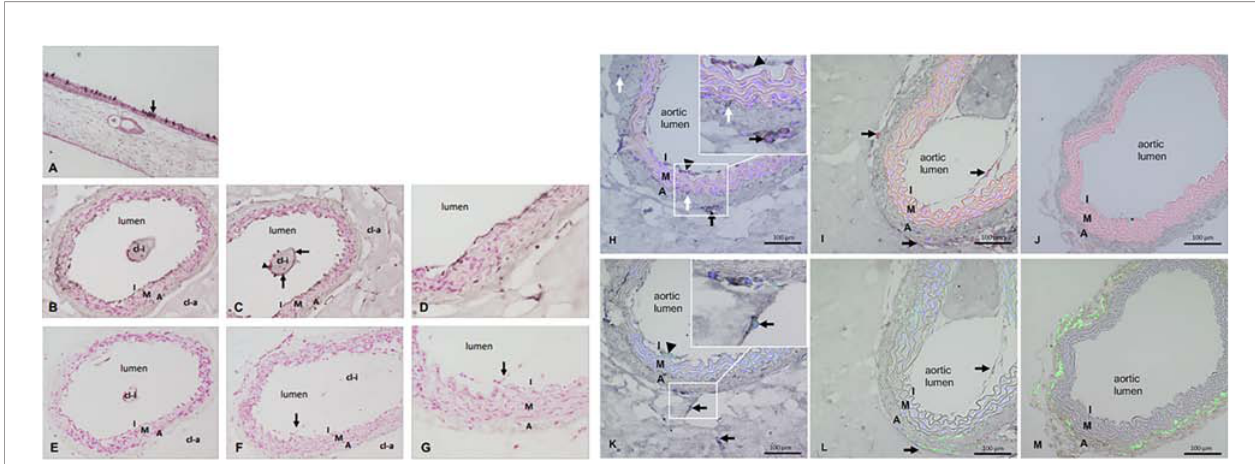
FIGURE 4 | (A – M) Immunostaining for SARS-CoV-2 and double immunostainings for SARS-CoV-2 plus ACE-2 or SARS-CoV-2 plus CD34. (A) SARS-CoV-2 staining of the nasal mucosa (used as positive control) and single epithelial cells show the dark signals (arrow) indicating SARS-CoV-2 infection. (B – D) Tissue sections of mouse aorta after ARA and SARS-CoV-2 infection. Dark signals in the innermost layer called intima (I). Single cells covering the collagen gel area inside the aortic lumen (cl-i) also stained positive for SARS-CoV-2 (arrows) while others are negative (arrowhead). (E) ARA section exposed to SARS-CoV-2 infection but treated by secondary antibody only in the immunostaining as control. (F – G) Tissue sections of ARA that were not exposed to SARS-CoV-2 infection but stained with both primary and secondary antibodies in the immunostaining procedure. Cells of the aortic intima that sprouted into the aortic lumen are also visible (arrow). Figure panels (A – G) Dark staining: SARS-CoV-2 staining, red staining: counterstaining with Calcium red, cl-i: collagen gel inside the aortic lumen, cl-a: collagen gel around the aortic wall, I: intima, M: media, A: adventitia. Figure panels (H – M) Double immunostainings for SARS-CoV-2 plus ACE-2 or SARS-CoV-2 plus CD34 on tissue sections of ARA and FIA. (H) : Co-localization of SARS-CoV-2 (dark signals) and ACE-2 (red) in intimal ECs and adventitial sprouting cells (arrowhead: intimal ECs; arrows: sprouting adventitial cells). Inset: higher magni fi cation demonstrates the clear co-localization of both dark and red staining signals in the aforementioned cells. Of note, some SARS-CoV-2 positive stained cells (white arrows, dark staining) remained negative for ACE-2. (I) only ACE-2 staining (red signals) are detectable in intimal ECs and adventitial sprouting cells (arrows) in ARA without exposure to SARS-CoV-2. (J) No speci fi c staining signals are detectable in the tissue section of FIA. Note the auto fl uorescence signals (red) of elastic laminae of the aortic wall. (K) Co-localization of SARS-CoV-2 (dark staining signals) and CD34 (green) in intimal ECs and sprouting adventitial cells (arrowhead: intimal ECs; arrow: sprouting adventitial cells). Inset: higher magni fi cation demonstrates the clear co-localization of both dark and green staining signals in the aforementioned cells. Note that tissue sections in (H) and (K) were prepared as serial sections from the same ARA, demonstrating a very similar pattern of cellular localization. (L) Only CD34 staining (green) is detectable in intimal ECs and sprouting adventitial cells (arrows) in ARA without exposition to SARS-CoV-2. (M) Only CD34 staining (green) is detectable in the wall of FIA, particularly strong in cells within the aortic adventitia as expected. I: intima, M: media, A: